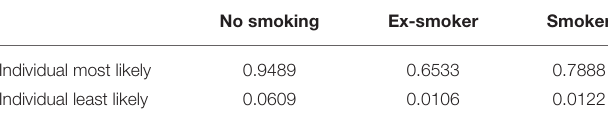
TABLE 5 | Predicted probabilities for each